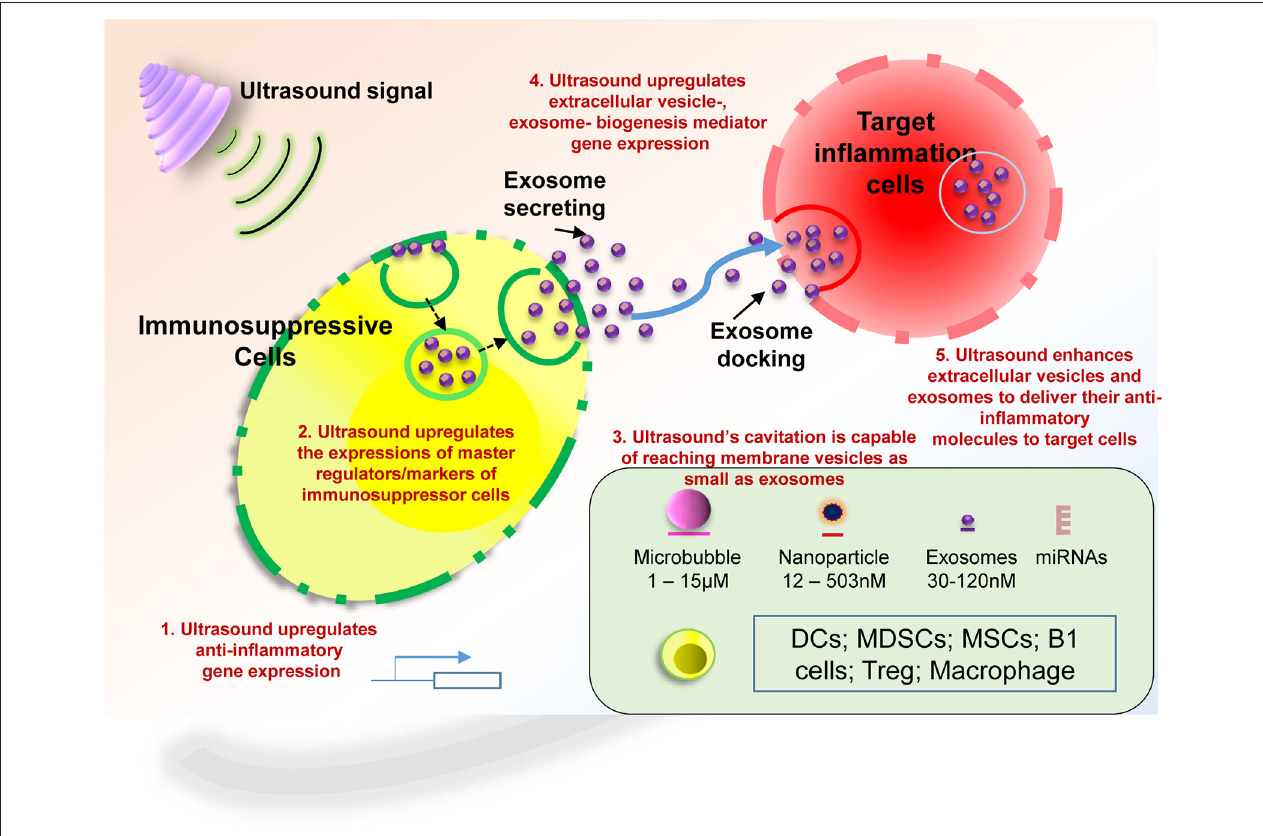
FIGURE 11 | Our novel working model which proposes the potential anti-inflammatory mechanisms utilized by LIUS to exert its beneficial effects. These potential mechanisms are as follows; (1) LIUS upregulates the expression of anti-inflammatory/immunosuppressive genes in the ultrasound-treated cells; (2) LIUS enhances the expression of the master regulators (markers) of immunosuppressor cells; (3) LIUS mediated cavitation is capable of reaching the membrane vesicles as small the expression of extracellular vesicles; and (4) LIUS increases exosome biogenesis and docking mediators, and (5) Ultrasound enhances extracellular vesicles and exosomes to deliver their anti-inflammatory molecules to target cells. Our new findings suggest that LIUS inhibits inflammation via above discussed novel mechanisms to make the target inflammatory cells become less inflammatory. DCs, dendritic cells; MDSCs, myeloid-derived suppressor cells; MSCs, mesenchymal stem cells; B1 cells, CD5 + B1 B cells; Treg, CD4 + Foxp3 + regulatory T